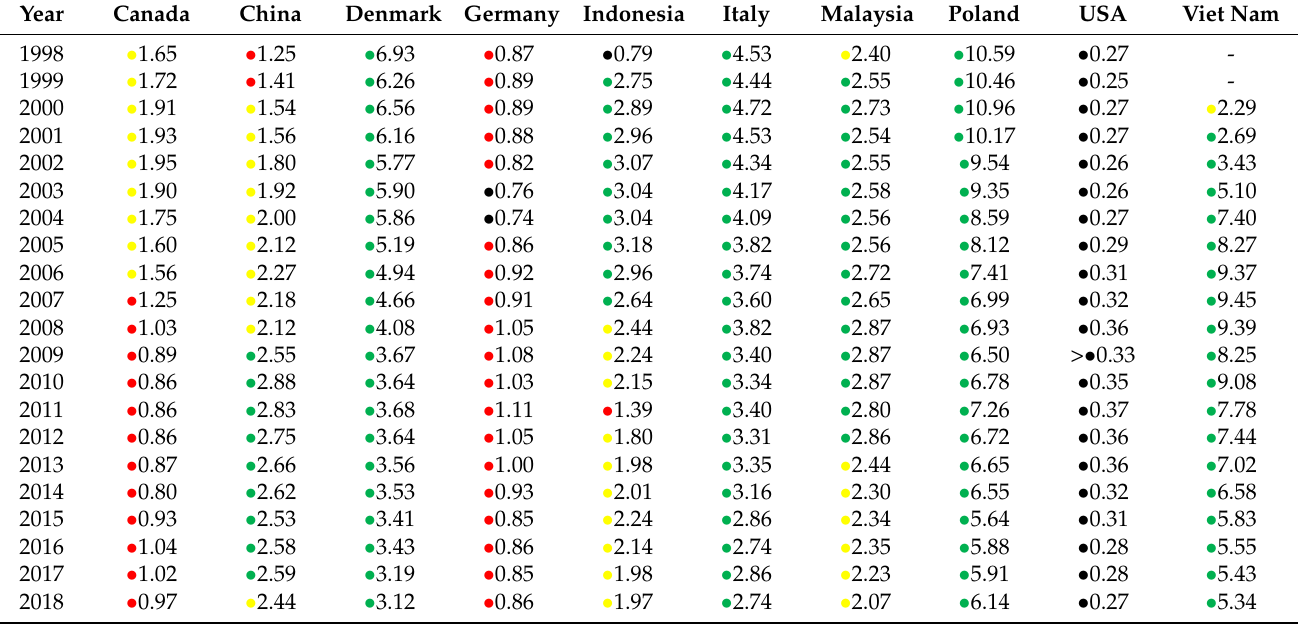
Table 3. RCA Index of the world’s major wooden furniture